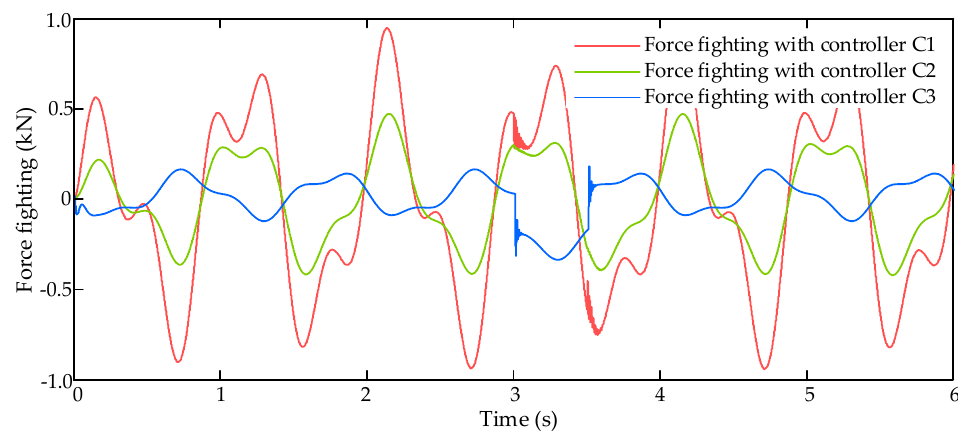
Figure 8. Force fighting results with dynamic signal input command.